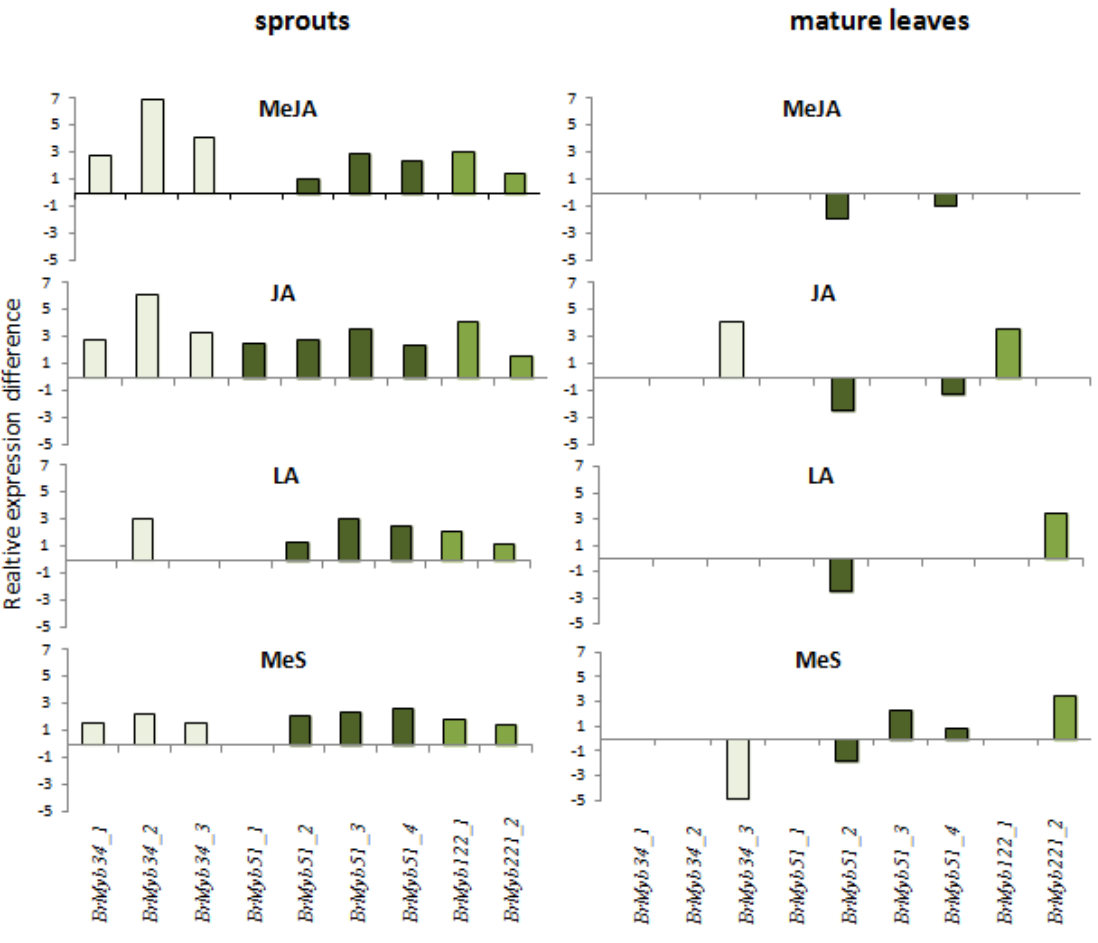
Figure 5. Relative expression difference of transcriptional regulators in sprouts and mature leaves. Left diagrams show expression in sprouts, right diagrams show expression in mature leaves treated with following elicitors: MeJA, methyl jasmonate; JA, jasmonic acid; LA, linolenic acid; MeS, methyl salicylate. Each value represents relative expression ratios calculated as ΔΔ CT from three biological replicates obtained from semi-quantitative RT-PCR analysis. For mapping the different abbreviations, please see Table 1. Only significant changes in gene expression levels after elicitor treatment compared to control plants are shown (Dunnett test, p < 0.05) (for details see basic data of gene expression levels in Table